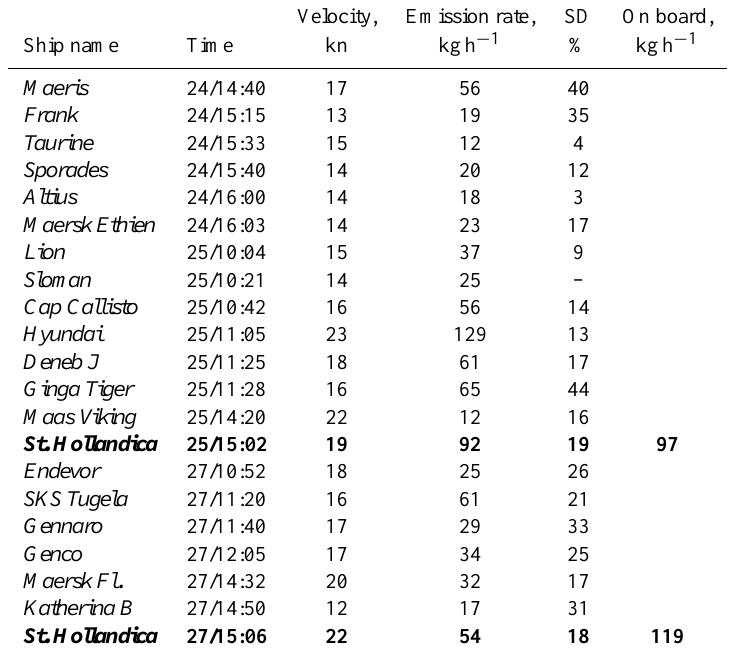
Table 4. SO 2 emission rates provided by helicopter-based DOAS measurements between 23 and 27 September 2009. For Stena Hollandica (in bold) also on board measurements are